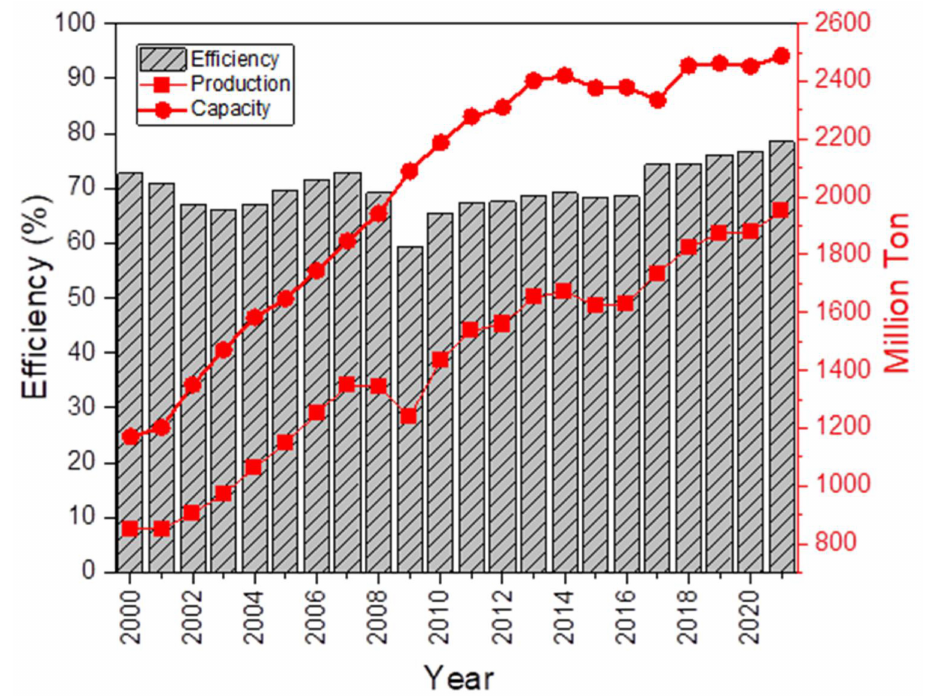
Figure 1. Global annual steel production, production capacity, and efficiency of the iron and steel production system (data till December 2021). Adapted from